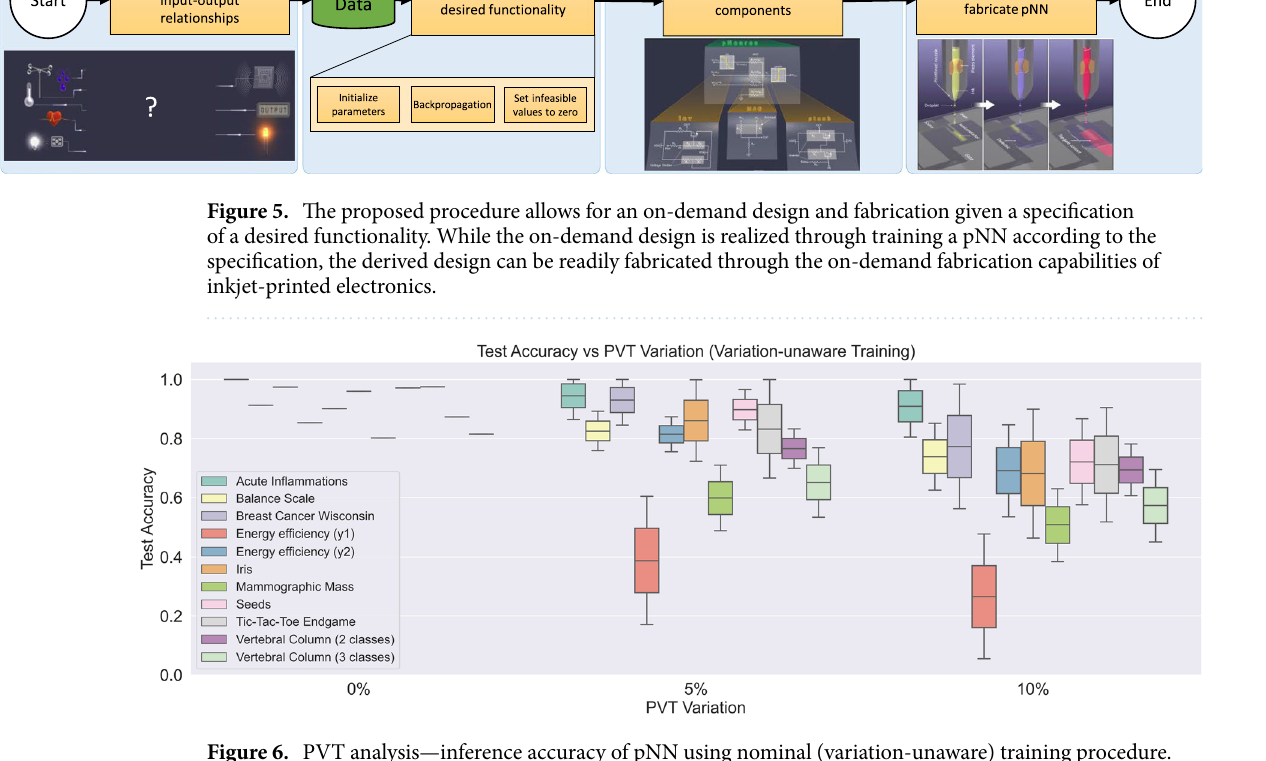
Figure 6. PVT analysis—inference accuracy of pNN using nominal (variation-unaware) training procedure. Variation parameter represents the coefficient of variation of the process, voltage and temperature variation models. The middle lines in the boxes refer to the mean test accuracy, while the whiskers depict the standard